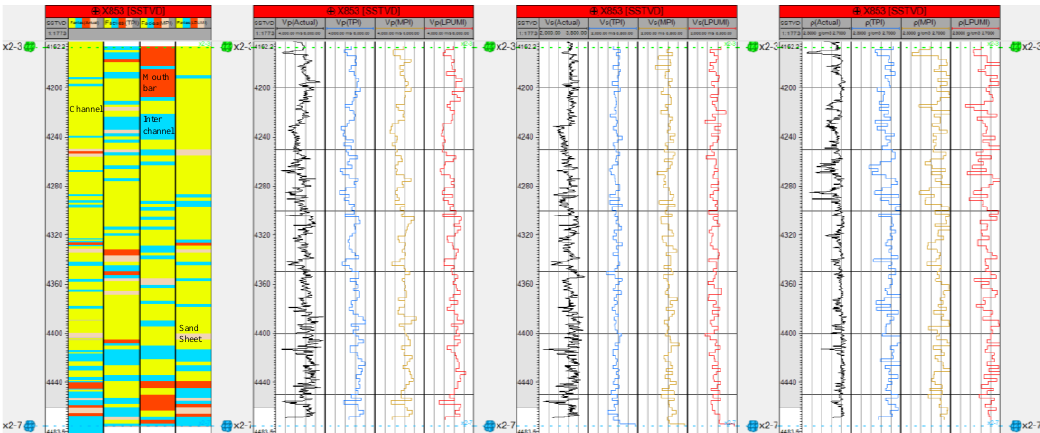
Figure 18. Comparison between the predicted results and the actual lithofacies and elastic parameters of the well.